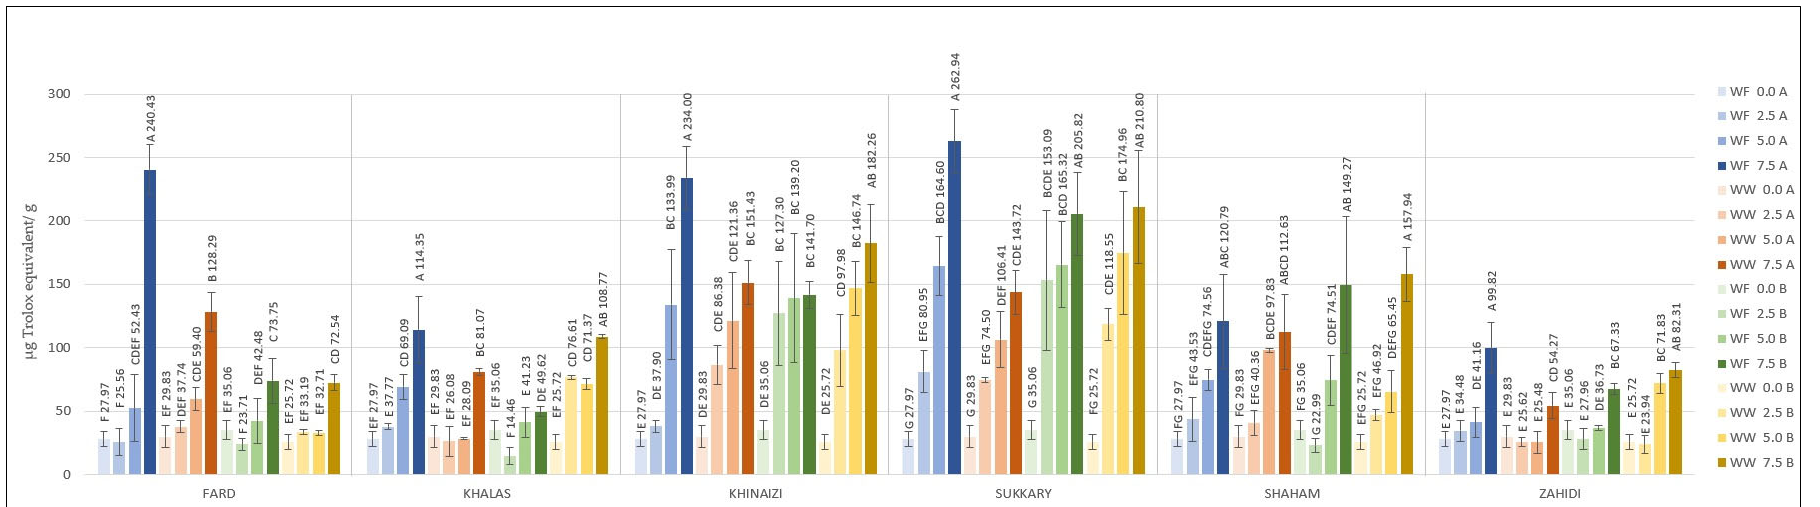
Figure 7. Ferric reducing antioxidant power, ( μ g equivalent Trolox/g) of composite cookies formulated with 2.5%, 5%, and 7.5 % substitution of flour by date seed powder. Different superscript letters in a variety denote significant differences, p < 0.05 (A ‐ 180 °C, B ‐ 200 °C).